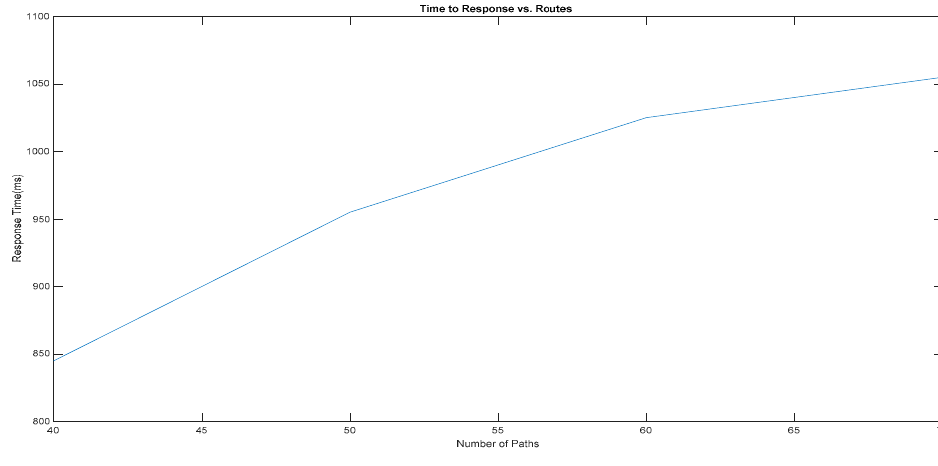
Figure 2. Time to response vs. routes.